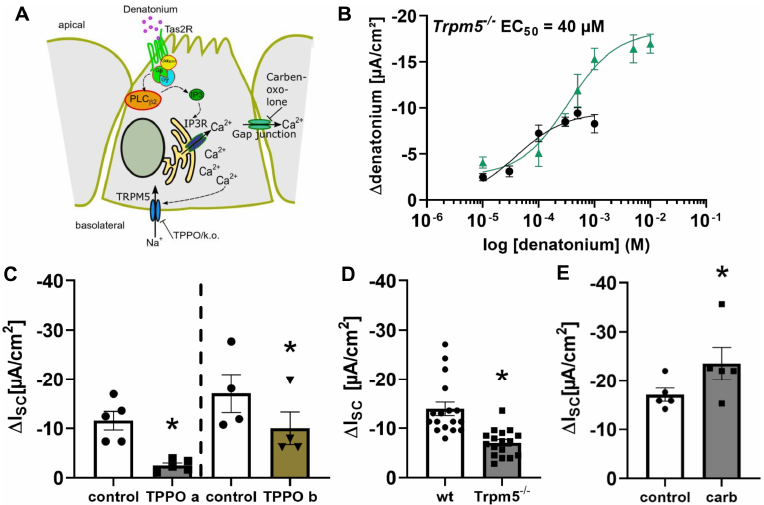
Figure 5. Role of the Trpm5 channel in the denatonium-induced current changes. ( A ) Schematic drawing of the bitter taste signalling cascade activated by denatonium in murine tracheal brush cells. ( B ) In Trpm5 − / − mice, the response to denatonium was concentration-dependent with an EC 50 of 40 µM ( n = 5 for each concentration, black curve). The corresponding curve from wildtype mice is depicted in green (data from Figure 1B). ( C ) The denatonium-induced current was reduced in the presence of the Trpm5 antagonist TPPO (triphenylphosphine oxide; 100 µM) when TPPO was applied apically or basolaterally in wildtype mice ( ∆ I SC , n = 5, * p < 0.05). ( D ) Comparison of the apical application of denatonium (1 mM) in the tracheae of wildtype (wt) and Trpm5 − / − mice. The denatonium-induced effect ( ∆ I SC ) was reduced in Trpm5 − / − compared to wt mice ( n = 17, * p < 0.05). ( E ) In the presence of the gap junction antagonist carbenoxolone (carb, 100 µM, apical and basolateral), the denatonium-induced effect was increased ( Δ I SC , n = 5, * p < 0.05).